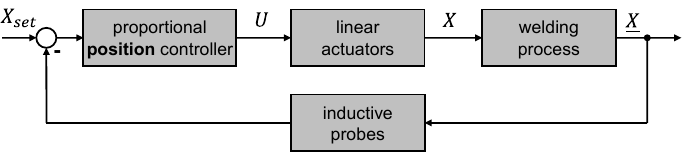
Figure 10. Closed-loop position control.